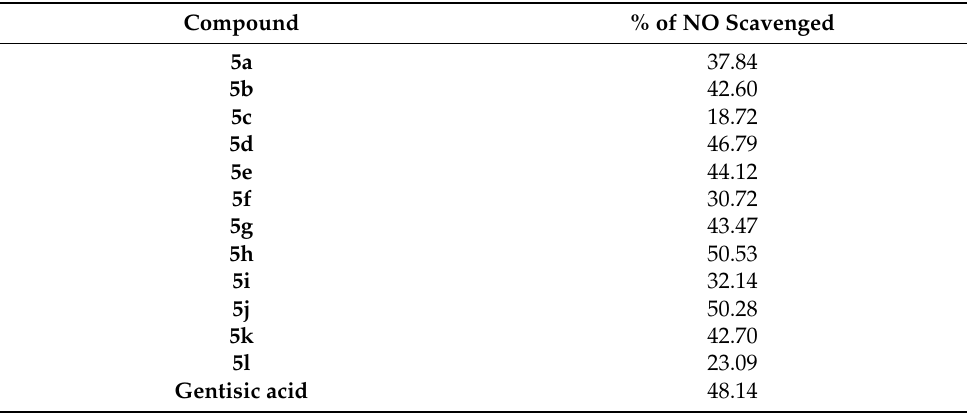
Table 3. Results of the NO scavenging